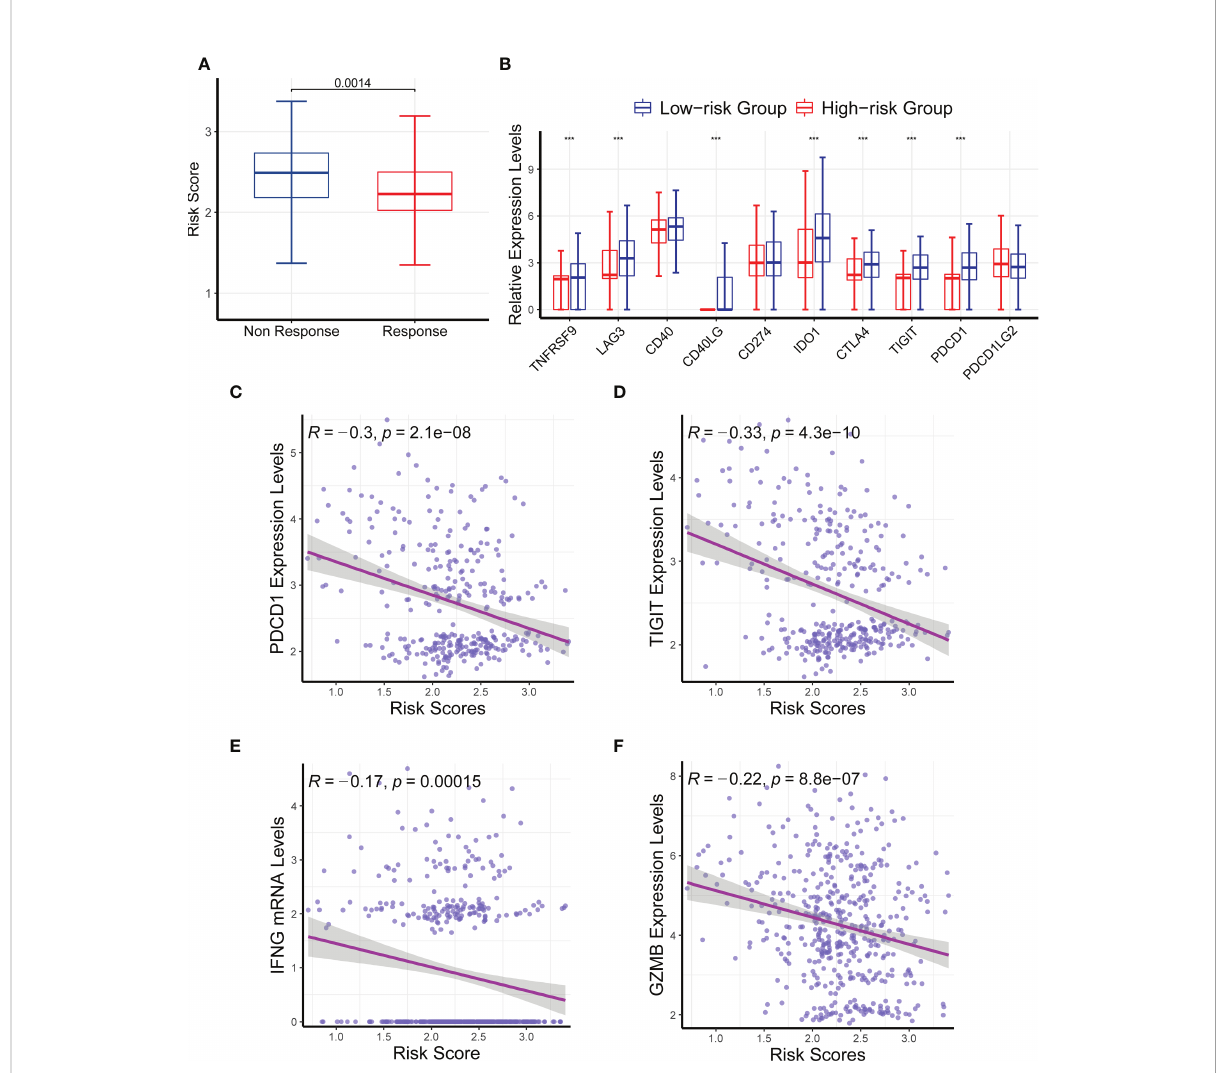
FIGURE 8 Effects of the circadian rhythm-related gene signature on drug response. (A) The nonresponders had a signi fi cantly higher risk score than the responders in The Cancer Genome Atlas. (B) The mRNA levels of TNFRSF9 , LAG3 , CD40LG , IDO1 , CTLA4 , TIGIT , and PDCD1 were signi fi cantly upregulated in the low-risk group compared with the high-risk group. (C – F) The risk score was signi fi cantly correlated with the expression levels of PDCD1 , TIGIT , INFG , and GZMB . *** P <